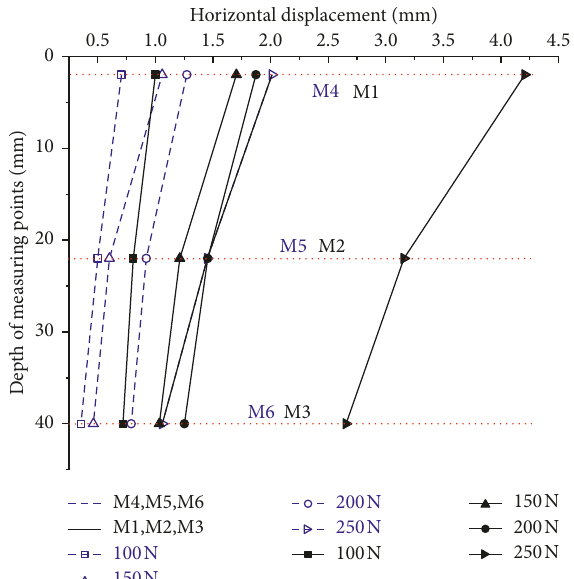
Figure 13: Horizontal displacement path of the characteristic particles.